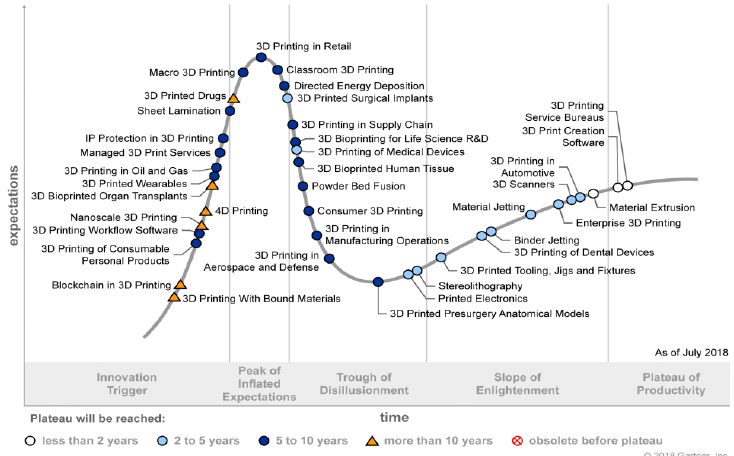
Fig. 2. Gartner hype cycle for 3D printing